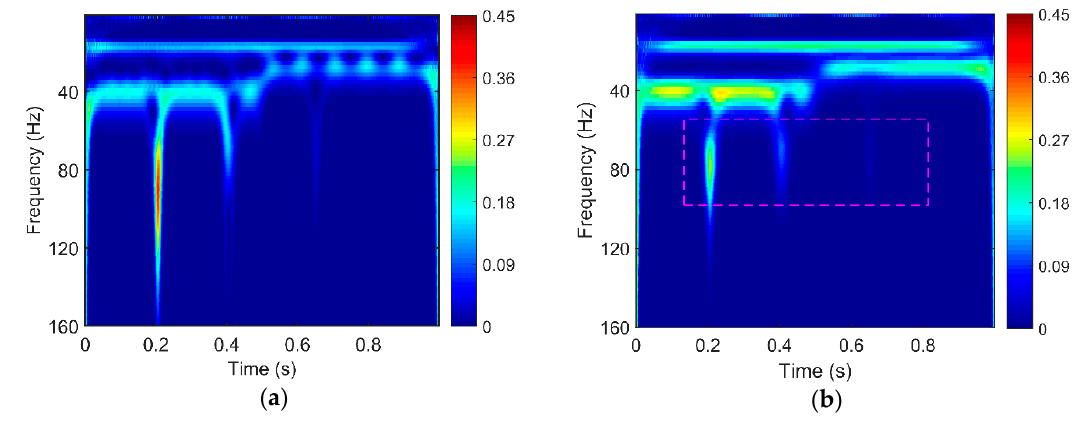
Figure 5. The instantaneous spectra of the synthetic signal obtained based on ( a ) the CWT/FWEO method; and ( b ) the VMD/CWT/FWEO method.